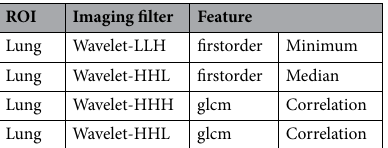
Table 3. Selected features by least absolute shrinkage and selection operator regression in the whole-lung- region radiomics analysis.